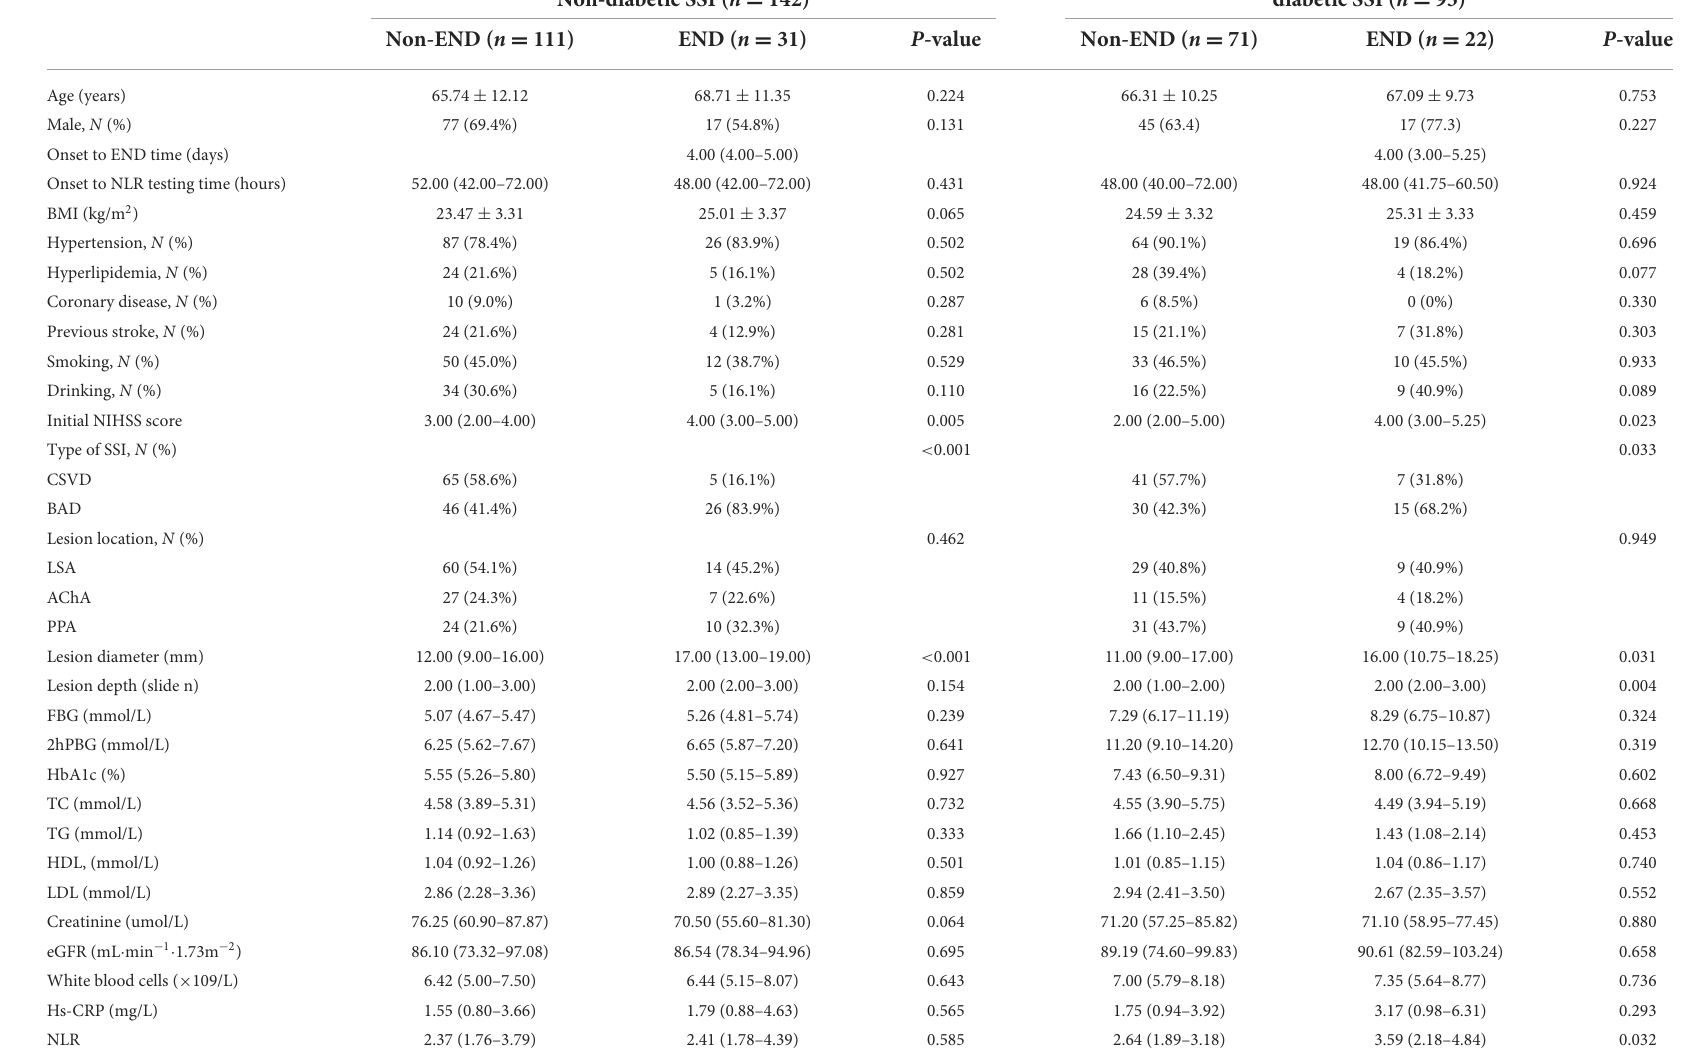
TABLE 2 Clinical characteristics of non-END and END groups in SSI patients with and without diabetes. Non-diabetic SSI ( n =